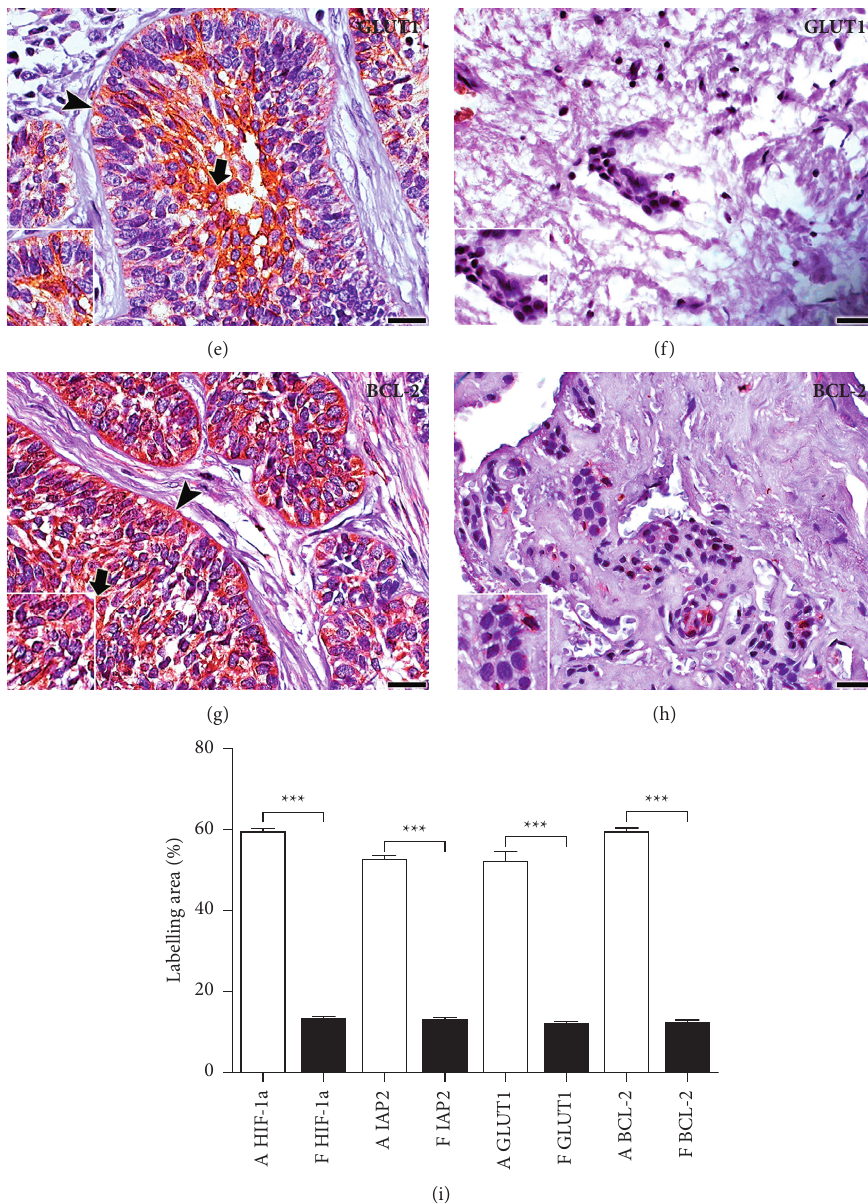
Figure 2: Immunomarking for HIF-1 α , IAP-2, GLUT1, and Bcl-2 in AMB and FP. HIF-1 α staining in AMB (a) was nuclear in the solid tumour area (arrowheads) and cytoplasmic and nuclear in cells near the cystic areas of the epithelial islets (arrow and cystic lumen, ∗ ). IAP-2 labelling on AMB (c) was predominant in the cytoplasm and nucleus (arrow) of the cells of the epithelial islands. Marking is also detected in selected cells from the basal and central layers (arrowhead and arrow, resp.). GLUT1 immunostaining in AMB (e) is predominant in the cytoplasm of the cells of the basal and central layer of the epithelial islands (arrowhead and arrow, resp.). Bcl-2 immunostaining in AMB (g) is predominant in the cytoplasm of epithelial island cells (arrow). Marking is also detected in selected cells from the basal and central layers (arrowhead and arrow, resp.). The FP shows a weaker labelling of the proteins IAP-2, GLUT1, and Bcl-2 compared with AMB (b, d, f, h). Scale 100 and 20 μ m. Comparison of immunoexpression of the HIF-1 α , IAP-2, GLUT1 and Bcl-2, and HIF-1 α in the ameloblastoma (a) and the follicle dental (f). ∗∗∗ p < 0 . 001